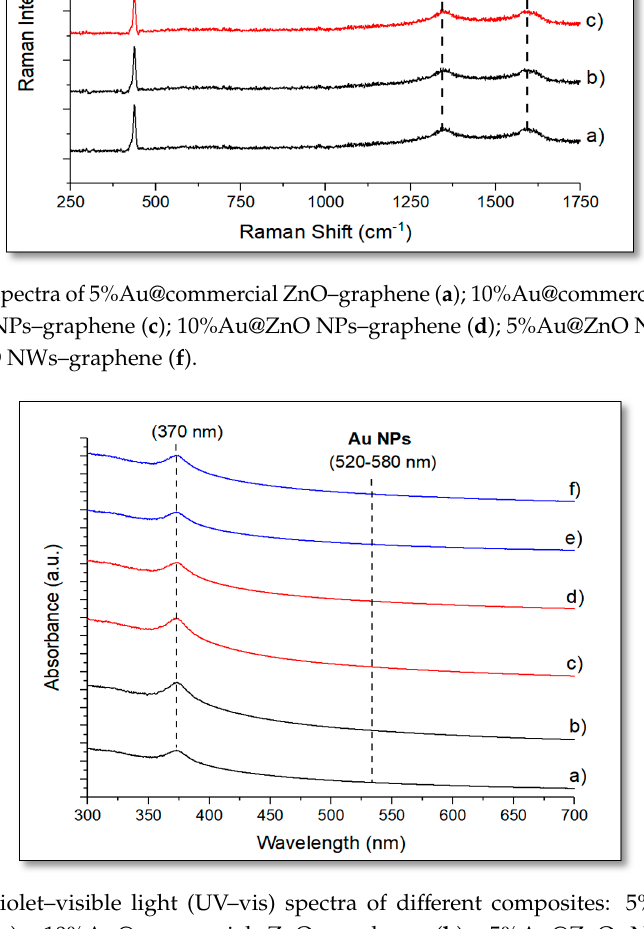
Figure 4. Ultraviolet–visible light (UV–vis) spectra of different composites: 5%Au@commercial ZnO–graphene ( a ); 10%Au@commercial ZnO–graphene ( b ); 5%Au@ZnO NPs–graphene ( c ); 10%Au@ZnO NPs–graphene ( d ); 5%Au@ZnO NWs–graphene ( e ); and 10%Au@ZnO NWs–graphene ( f ).